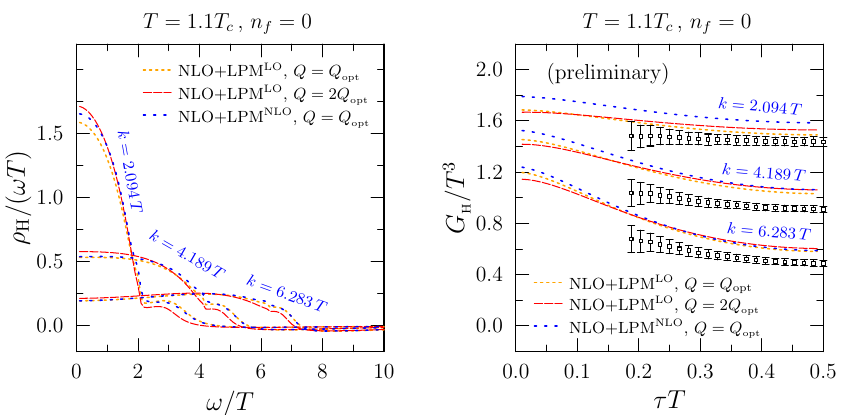
Figure 2. Results for ρ H (left) and the corresponding Euclidean correlation function, calculated from eq. (6), (right) at T = 1 . 1 T c for n f = 0. Similar plots for ρ V (and G V ) may be found in ref.